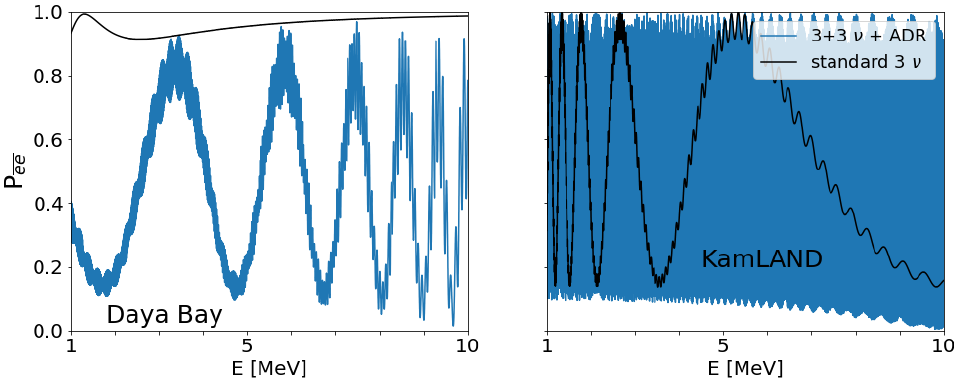
Figure 6 . Comparison between the predictions of the three neutrino standard picture and the 3+3 model with altered dispersion relations for Daya Bay (left) and KamLAND